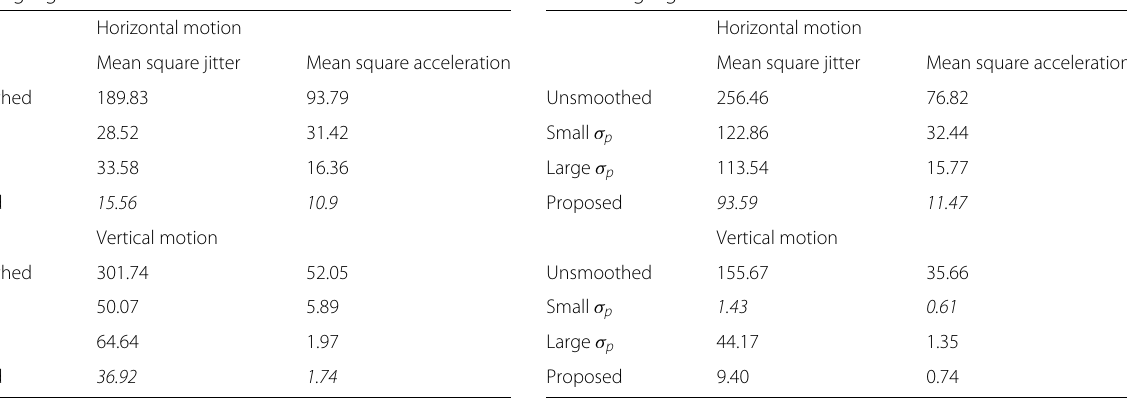
Table 2 Numerical comparison between different motion smoothing algorithms for video 1 smoothing algorithms for video